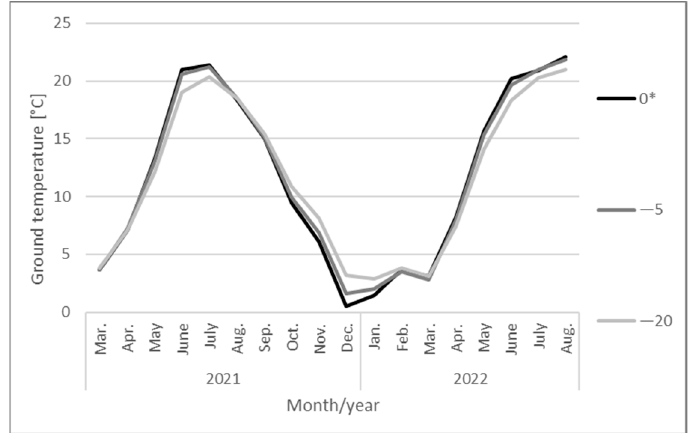
Figure 3. The average soil temperature at ground level and at depths of 5 cm and 20 cm [°C] during the growing seasons: year of establishment of flower strip (2021) and year of observations (2022); * measurement depth [cm]: 0 means at the ground level; —5 means 5 cm below the ground surface; —20 means 20 cm below the ground level.